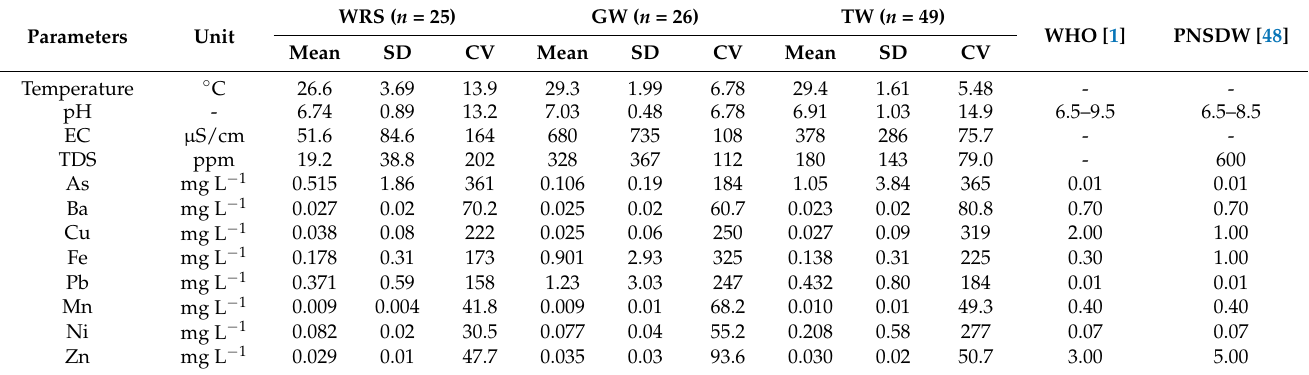
Table 6. Mean values of physicochemical parameters and HMM